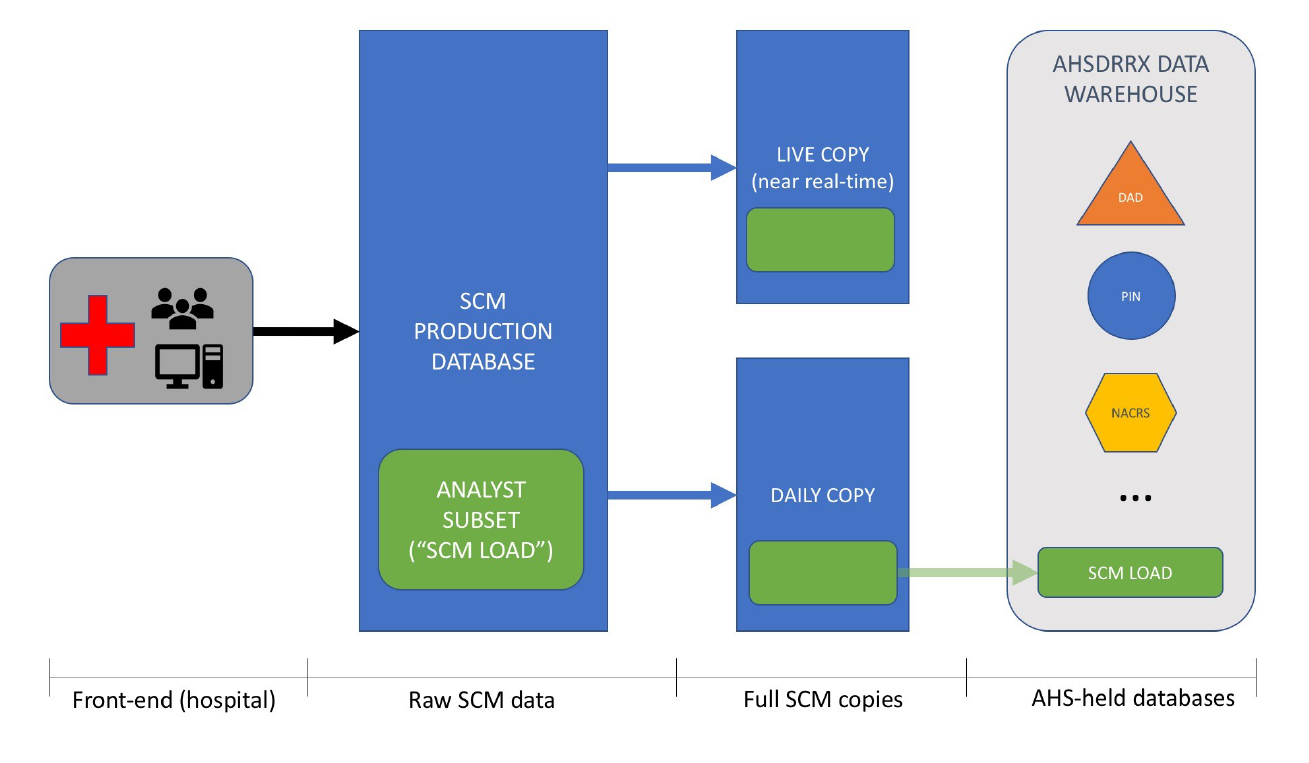
Figure 1: Flow Diagram Depicting the Data Flow from the Front End to the Back End of SCM EHR system.